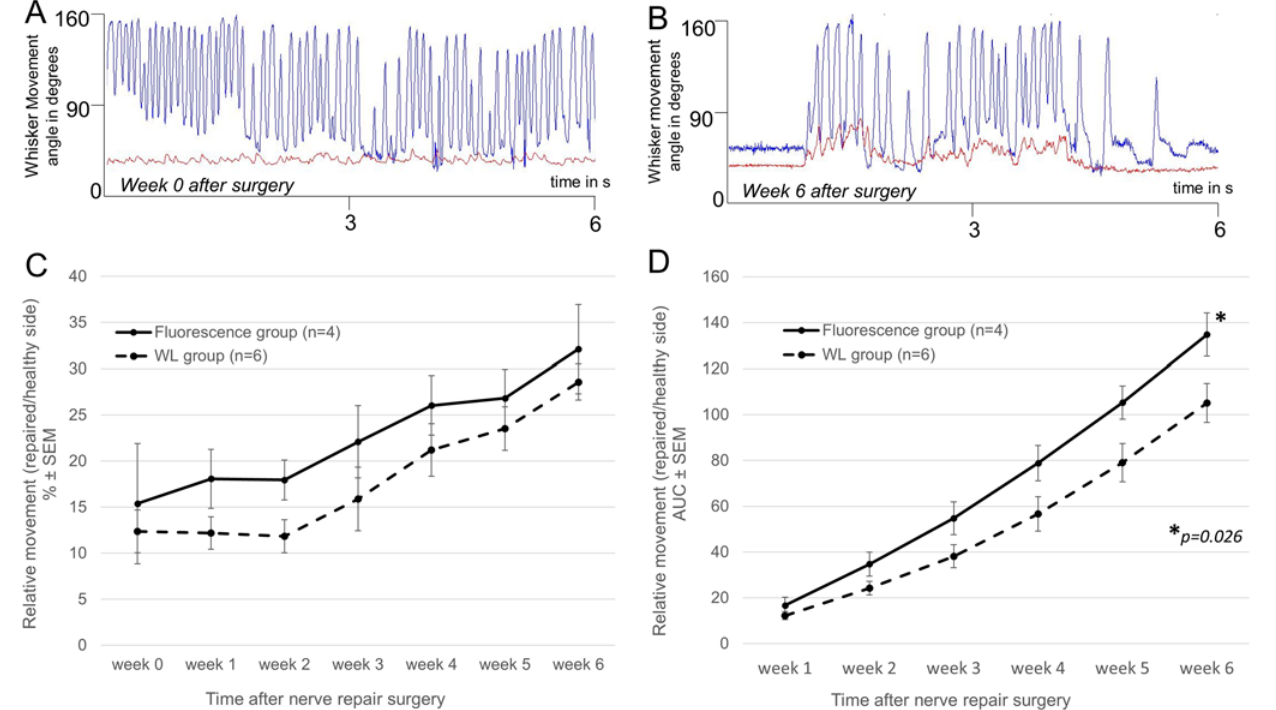
Fig 5. Assessment of functional recovery after facial nerve repair. A. Representative whisker movement amplitude plot of a repaired whisker immediately after surgery (red line) and the contralateral healthy whisker (blue line) obtained over a 6-second period of continuous whisking using automated whisker tracking technology. The repaired whisker shows only small fibrillations indicating complete denervation. B. Representative whisker movement amplitude plot of a repaired whisker 6 weeks after surgery (red line) and the contralateral healthy whisker (blue line) obtained over a 6-second period. The repaired whisker shows recovery of movement. C . Relative postoperative whisker movement amplitude, i.e. repaired side movement in % of healthy side movement. D. Cumulative functional improvement (area under curve — AUC) calculation showing there was faster functional recovery improvement in the FL (solid line) group compared to WL (stippled line). Student ’ s one- sided t test p value provided at the final time point.